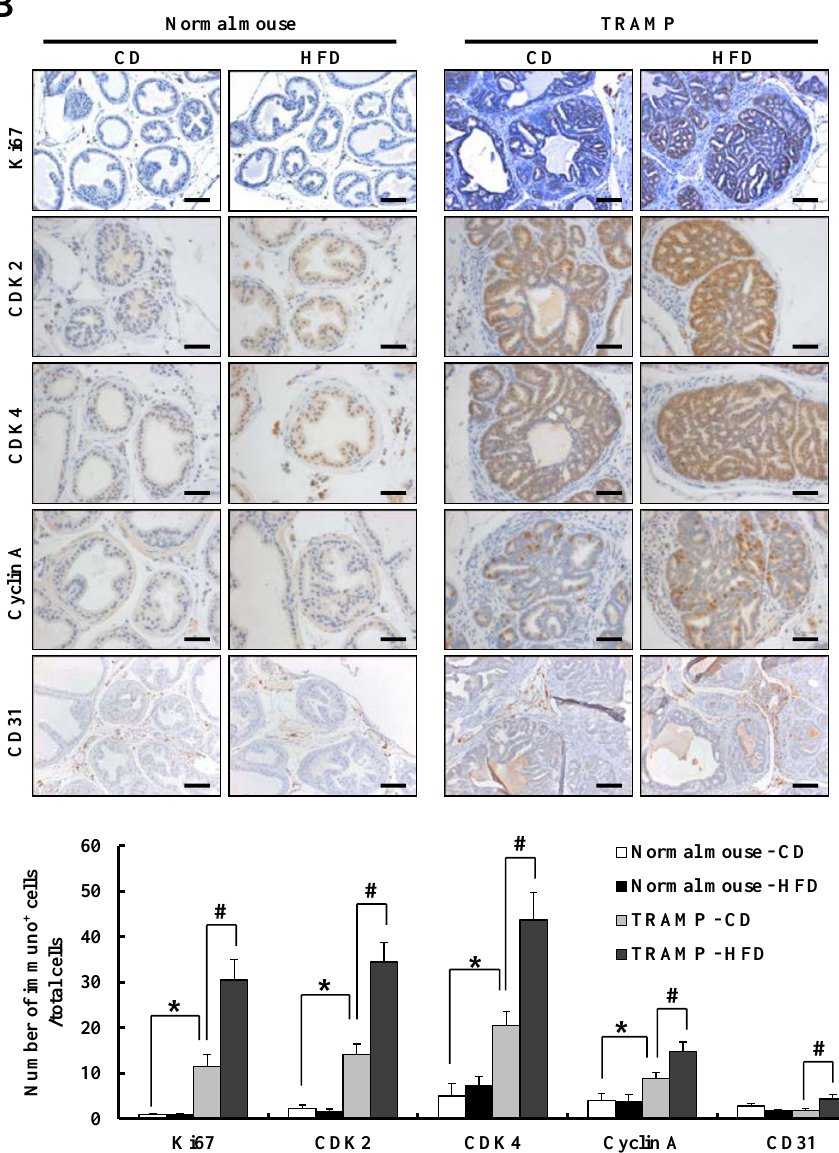
Figure 3. HFD feeding increases prostate cancer development in TRAMP mice. Male TRAMP mice and their nontransgenic littermates at four weeks of age were fed a CD or HFD for a period of 20 weeks. All mice were sacrificed at 24 weeks of age, and the prostate was removed and fixed in 4% paraformaldehyde. ( A ) Prostate sections were stained with H&E. Each bar represents the percentage (mean ± SEM) of each pathologic grade in the dorsolateral lobes of the prostate (DP) of TRAMP mice ( n = 12). * p < 0.05 as compared with the CD-fed TRAMP group. PIN, prostatic intraepithelial neoplasia; WDC, well-differentiated carcinoma; PDC, poorly-differentiated carcinoma; ( B ) Prostate sections were stained with the indicated antibodies, and nuclei were counterstained with hematoxylin. Representative images of IHC staining (upper panel) and quantification results (lower panel) are shown. Each bar represents the mean ± SEM ( n = 6 (normal mouse) or 8 (TRAMP)). * p < 0.05 as compared with the CD-fed normal mice group. # p < 0.05 as compared with the CD-fed TRAMP group. Scale bar, 100